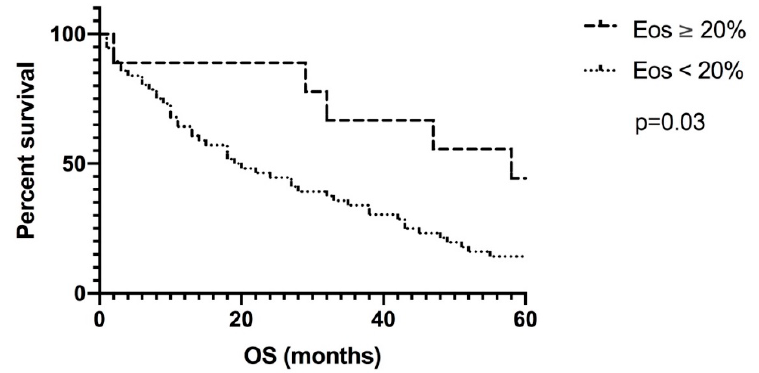
Figure 2. Intention-to-treat analysis for a cut-off of 20% eosinophils in peripheral blood. DC-vaccinated patients who developed eosinophilia ≥ 20% at any point during the course of vaccinations showed a clear trend toward longer survival ( p = 0.03). In these patients, survival was prolonged with a median of 58 months (range 2–111 months; n = 9), compared with a median of 20 months (range 0–119 months; n = 58).Eos: eosinophilia; OS: overall